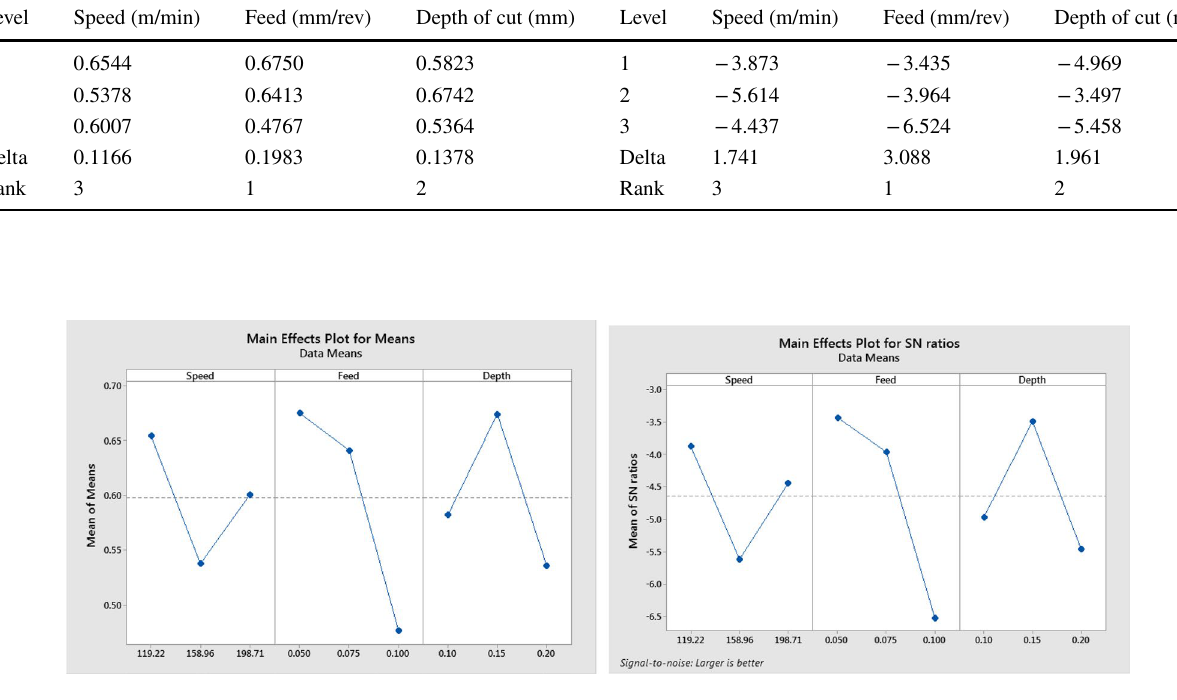
Fig. 6 Main effect plot of mean and S/N ratio